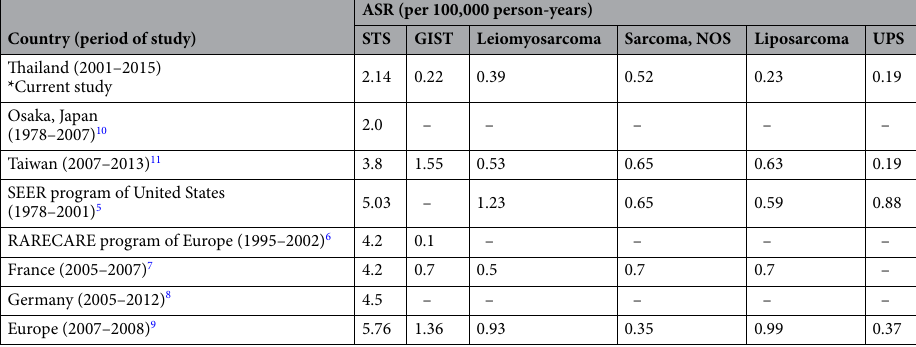
Table 2. Age-standardized incidence rates of soft tissue sarcoma by major histological type and gastrointestinal stromal sarcoma in Thailand and from comparable registries in other countries. The ASR was adjusted to the Segi world standard